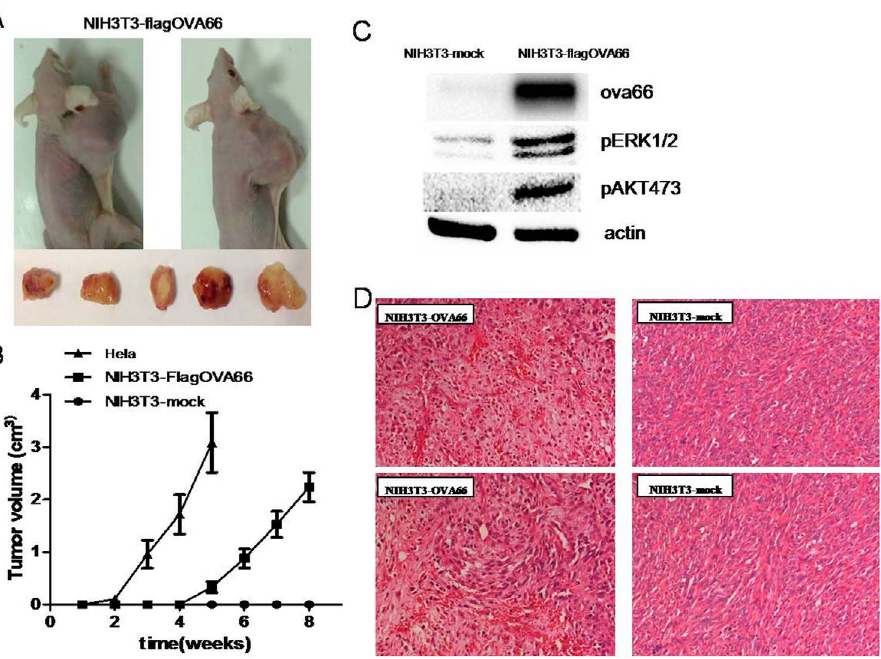
Figure 5. Tumor formation. A. Overall view of tumors formed by NIH3T3-flagOVA66. Tumors in nude mice were seen after injection with NIH3T3- flagOVA66, or with typical OVA66 highly-expressed HeLa tumor cells, whereas none were seen after injection with NIH3T3-mock cells. B. Tumor growth curves for nude mice of different experimental groups (n=3) C. Western blotting of total proteins extracted from tumors formed by NIH3T3- flagOVA66 and tissues where NIH3T3-mock cells were injected, using actin as a loading control. D. HE staining of tissues from mice inoculated with NIH3T3-flagOVA66 and NIH3T3-mock, respectively (200 6 ).